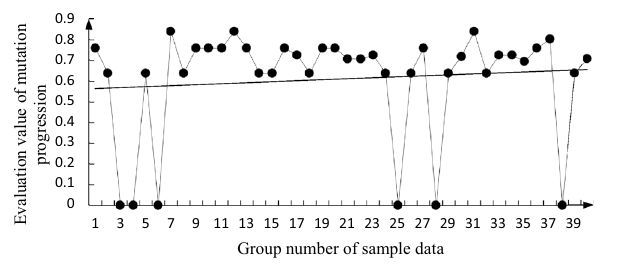
Figure 3. Change trend graph for x F 2